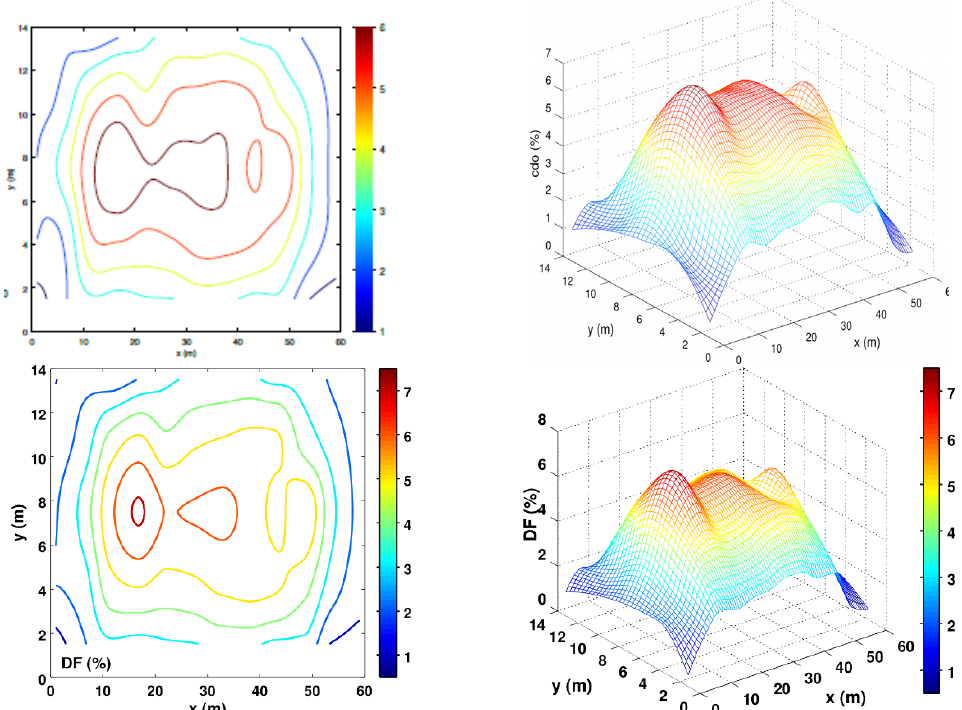
Figure 10. Daylight factor DF (%) in the hall with different surface colors (various reflectance).